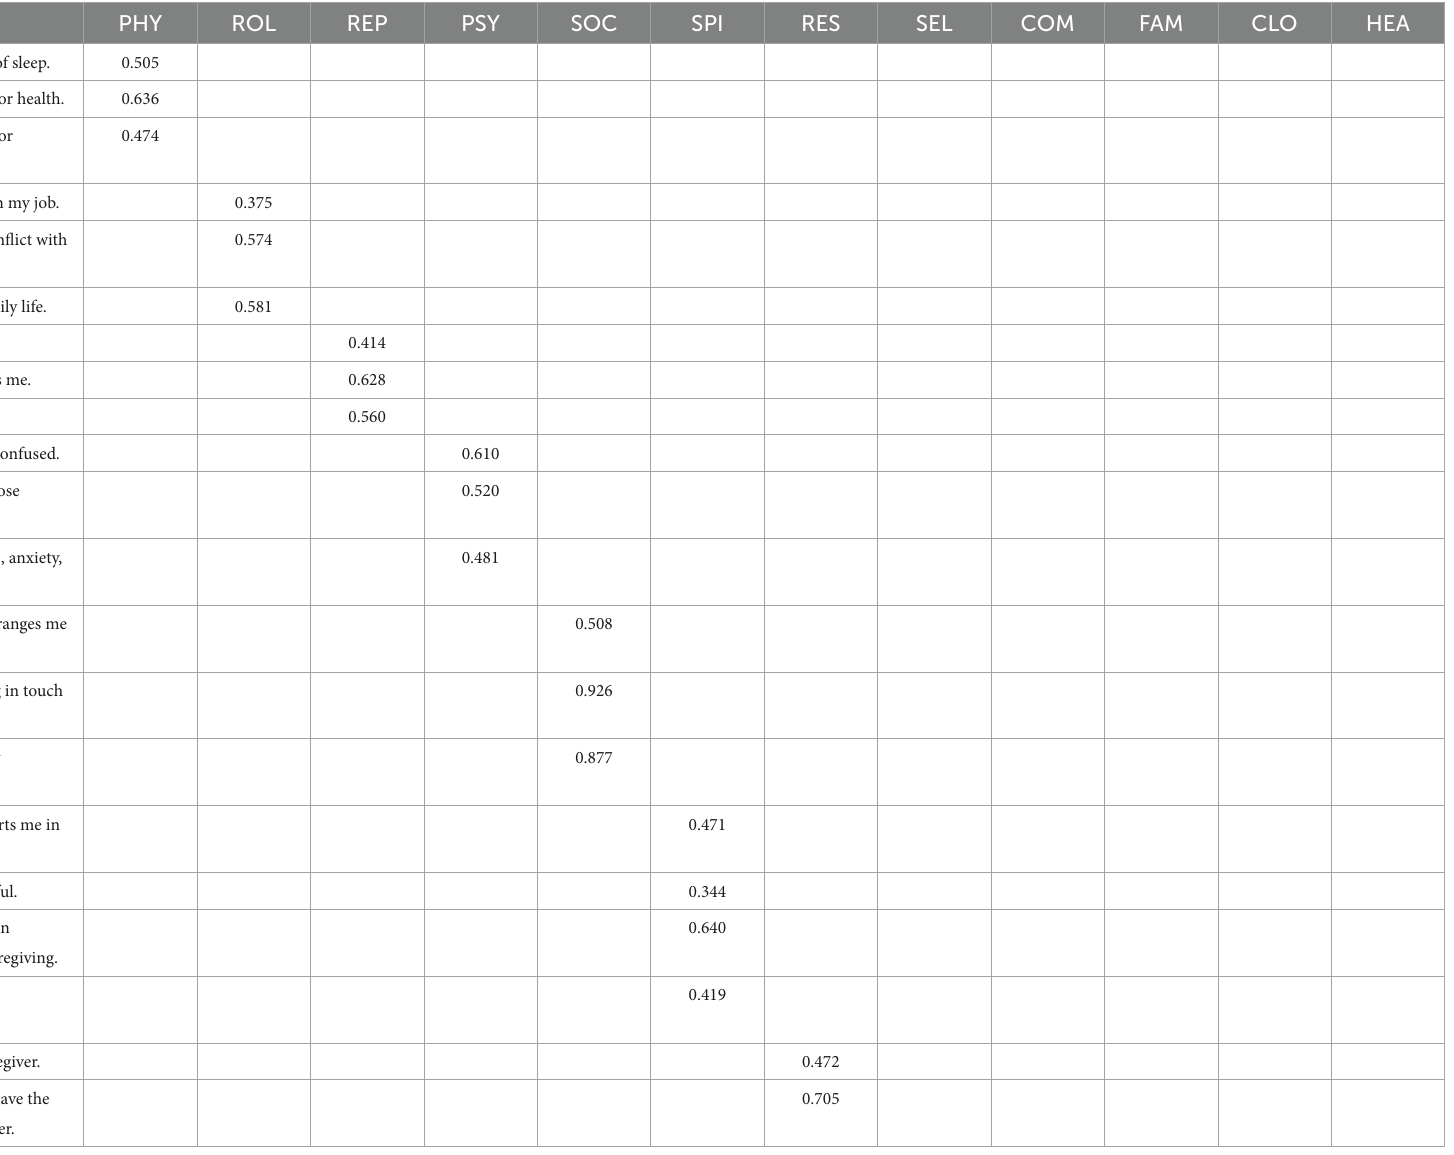
TABLE 1 Factor loadings of the 36 items of the Caregiver Needs and Resources Assessment ( N =